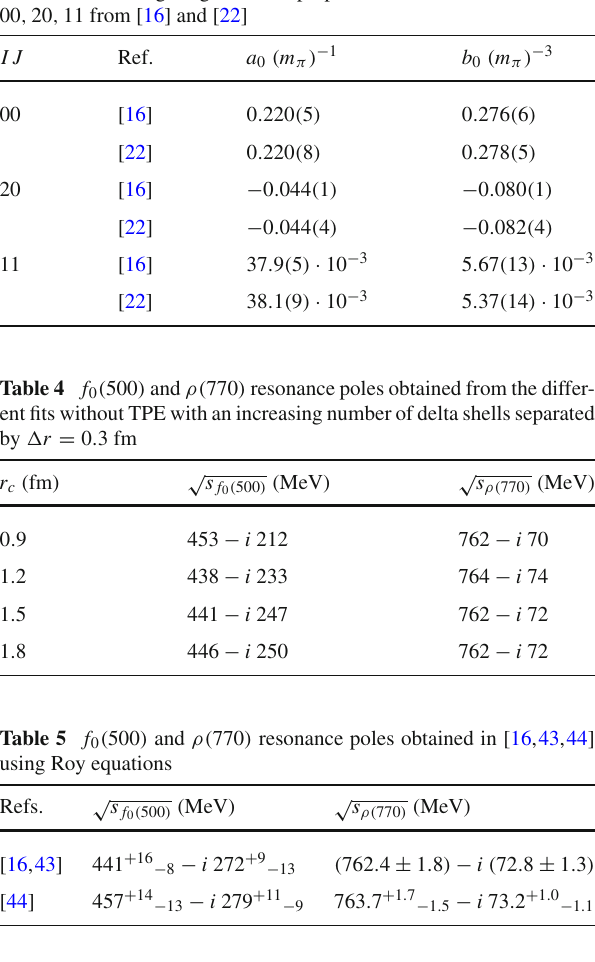
Table 3 Scattering length and slope parameter values for the I J = 00 , 20 , 11 from [16] and [22]